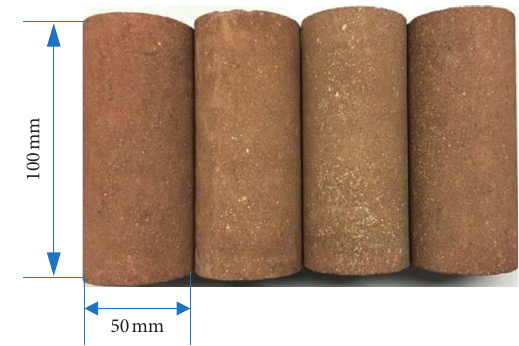
Figure 1: Rock sample of sandstone.